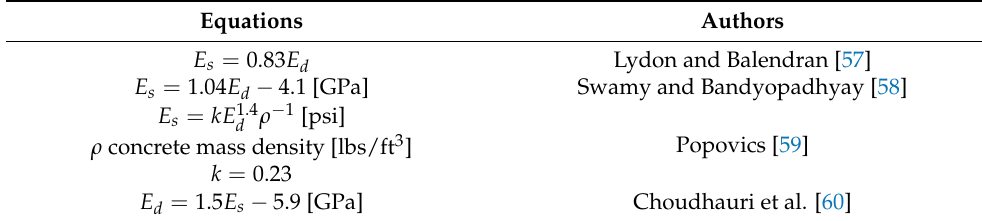
Table 1. Relationships between E d and E s available in the literature.